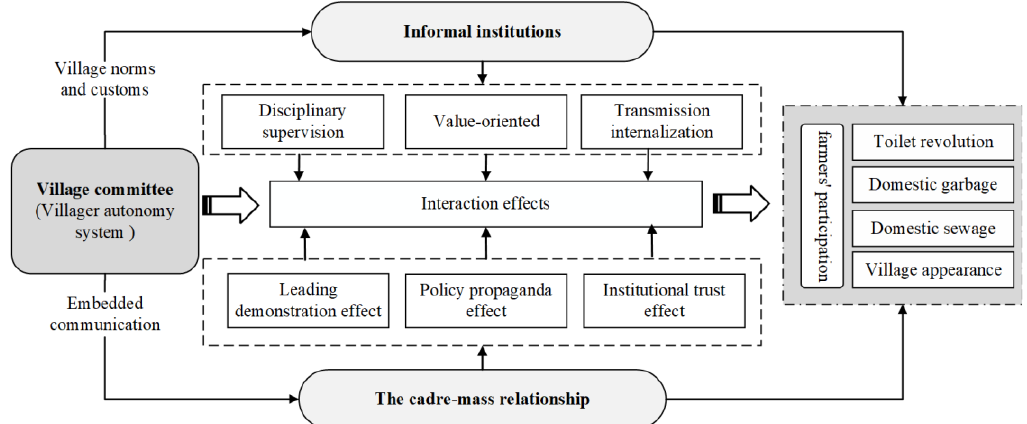
Figure 1. The Influence Mechanism of informal institutions and CMR on Farmers’ Participation in RRE Governance.